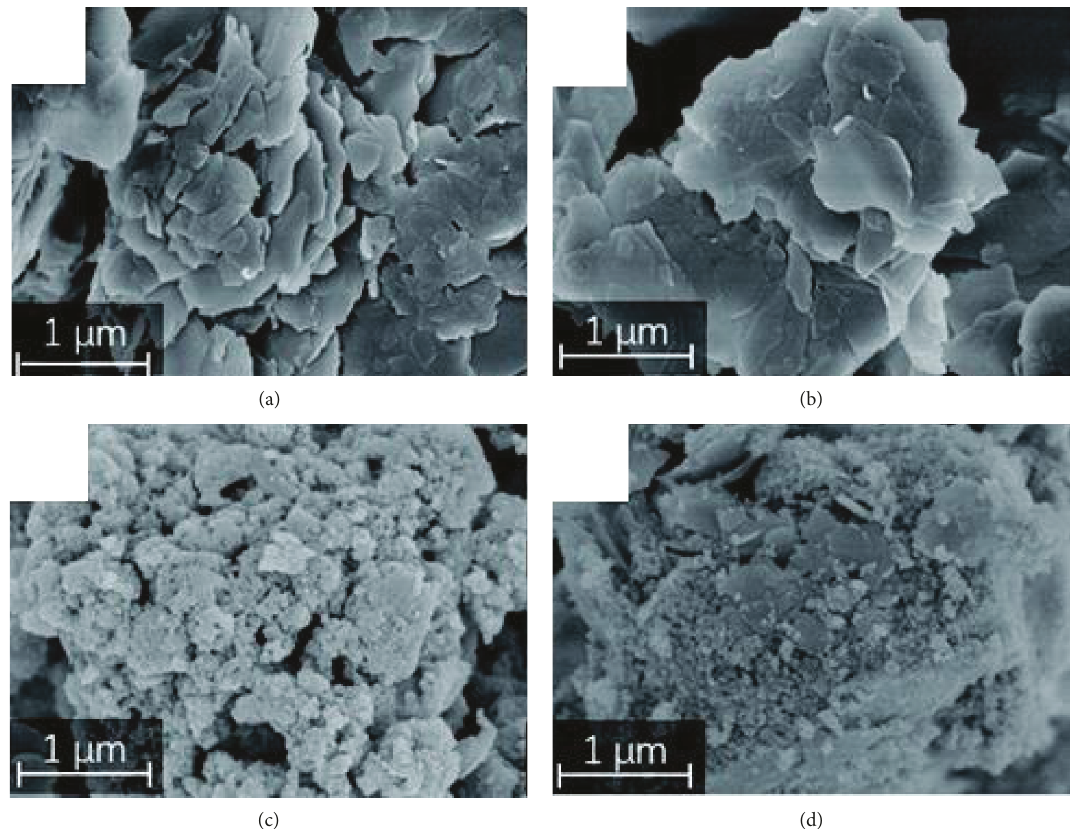
Figure 3: SEM images of (a) medical talc (MT), (b) medical talc after calcining at 400 ° C (T-400), (c) hydrolyzing TiO after calcining at 400 ° C